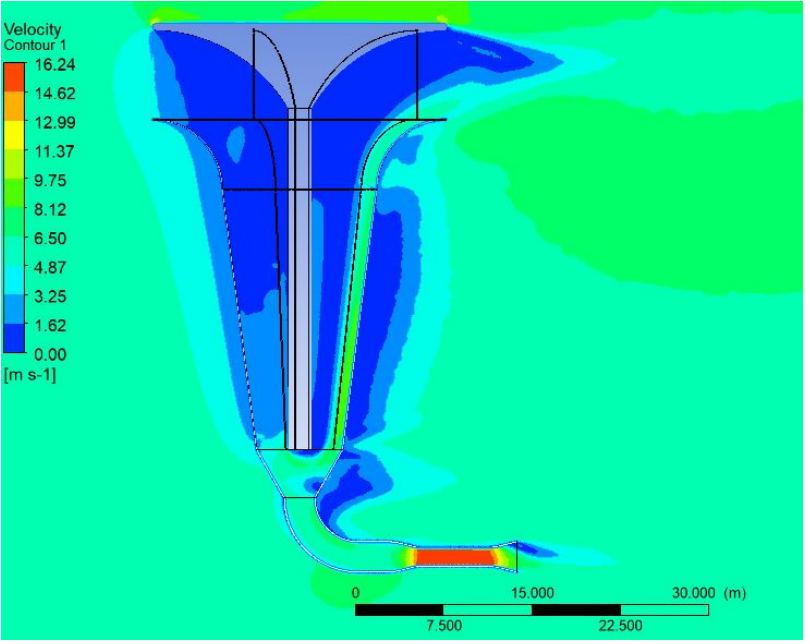
Figure 4. Velocity contour of the omni-directional wind funnel.